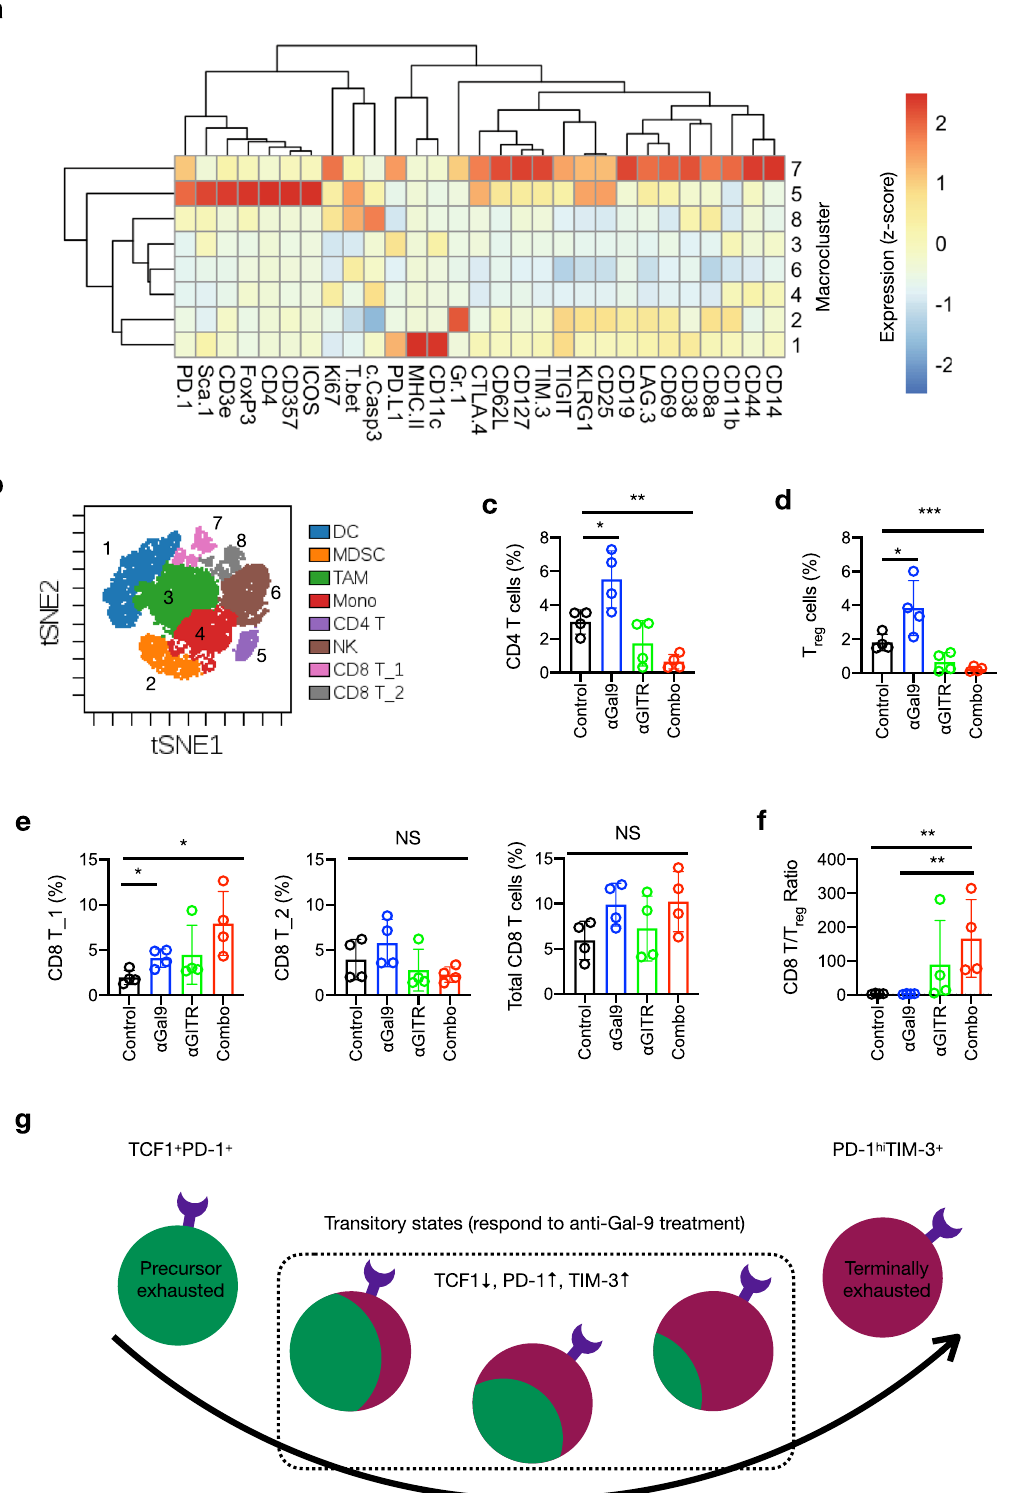
contributes to the persistence of exhausted T cells in tumors.